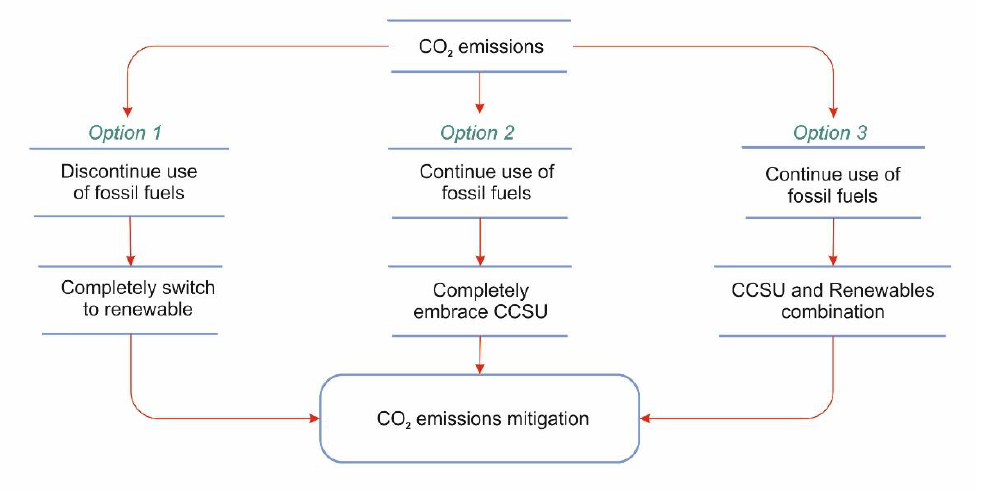
Figure 3. A general roadmap towards minimizing global CO 2 emissions.